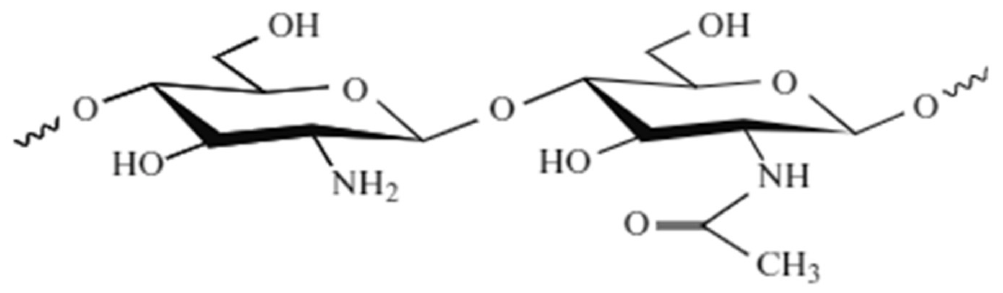
Figure 4. Chemical structure of chitosan [26].